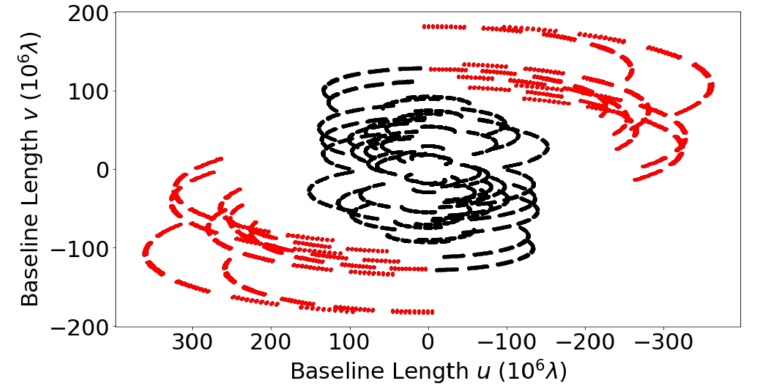
Figure 1. The uv coverage for the M87 session. Red curves indicate baselines related to NSRT. M87 was observed along with 3C 273, 1219 + 044, and M84. Within the 7-hour ses- sion, M87 was observed for 6 scans at 47 min per scan. The recording rate was 1 Gbps (2-bit sampling), where a total bandwidth of 256 MHz was divided into eight 32 MHz intermediate-frequency (IF) bands. Only left-hand circular polarization was